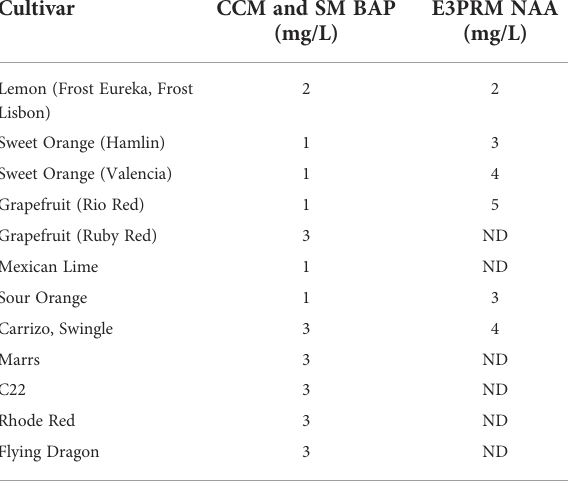
TABLE 2 Final BAP and NAA concentrations used for co-cultivation, selection, and rooting media for the different varieties.